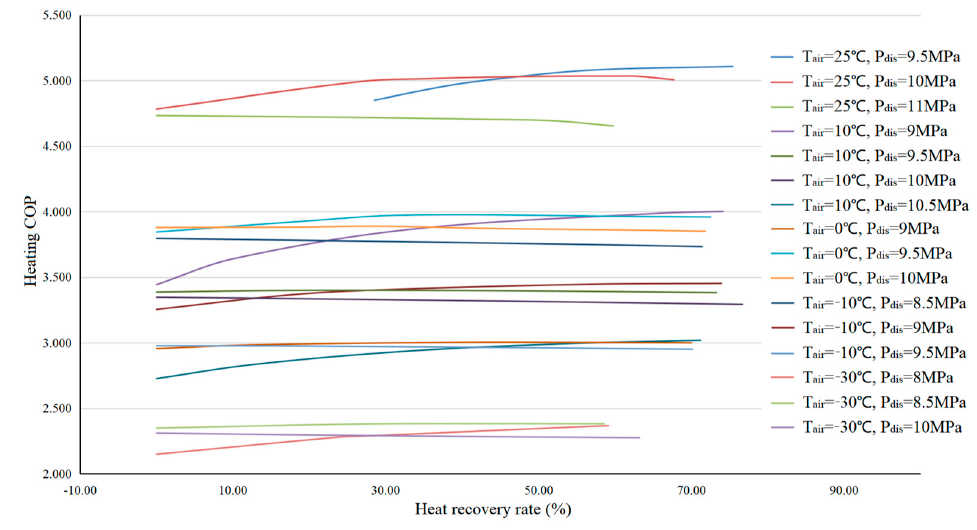
Figure 4. The sketch map of the optimal heat recovery rate in the transcritical CO 2 system.